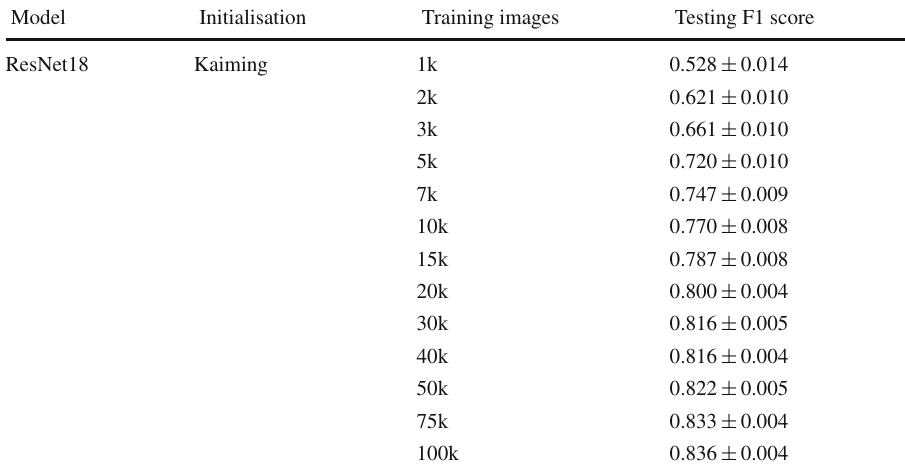
Table 1 The F1 scores for the testing sample for the Kaiming initialised networks. The values and uncertainties given come from the mean and error on the mean of 25 different training